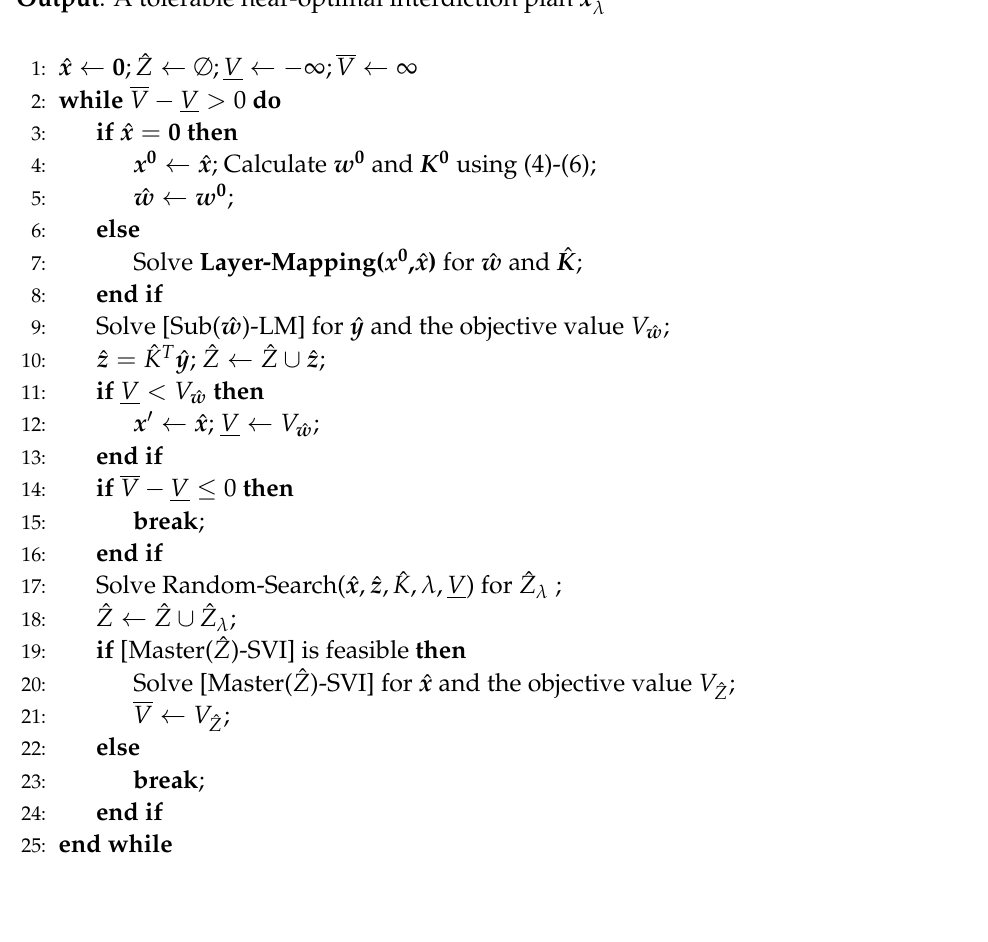
Algorithm 4 Improved decomposition algorithm with Layer-Mapping and